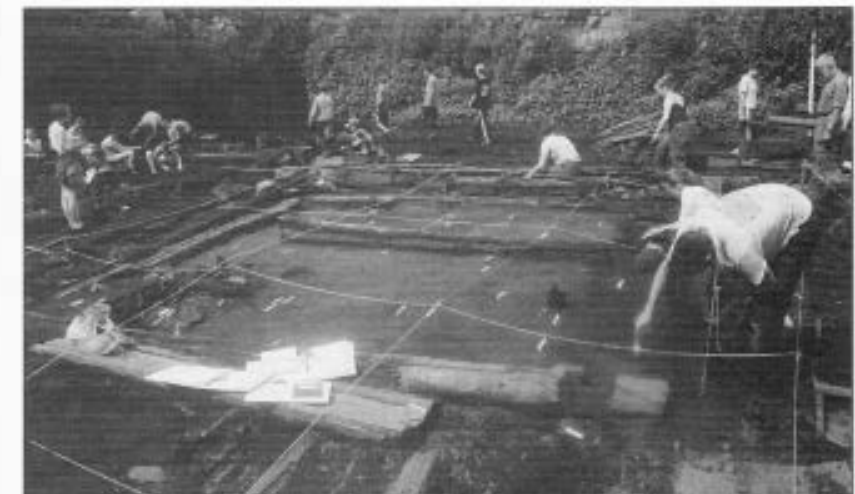
Figure 2 Single context area excavation at the Troitsky XII site, 1998; view from the southwest.